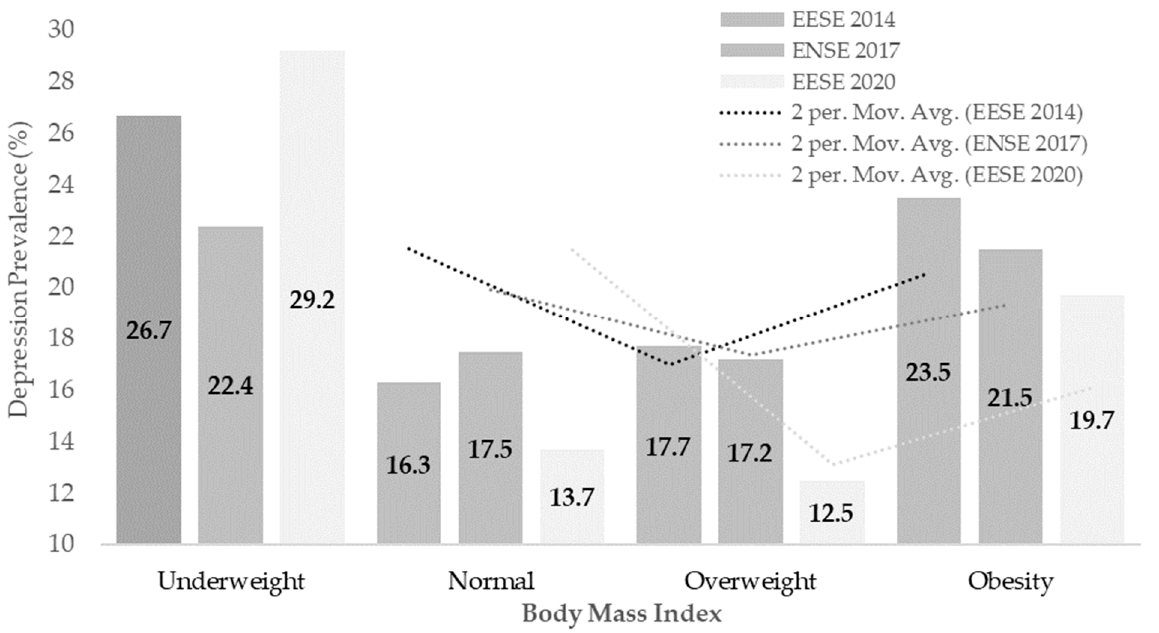
Figure 4. Depression prevalence according to the Body Mass Index Group in the Spanish population in the three surveys EESE2014, ENSE2017, and EESE2020. in the three surveys EESE2014, ENSE2017, and EESE2020.